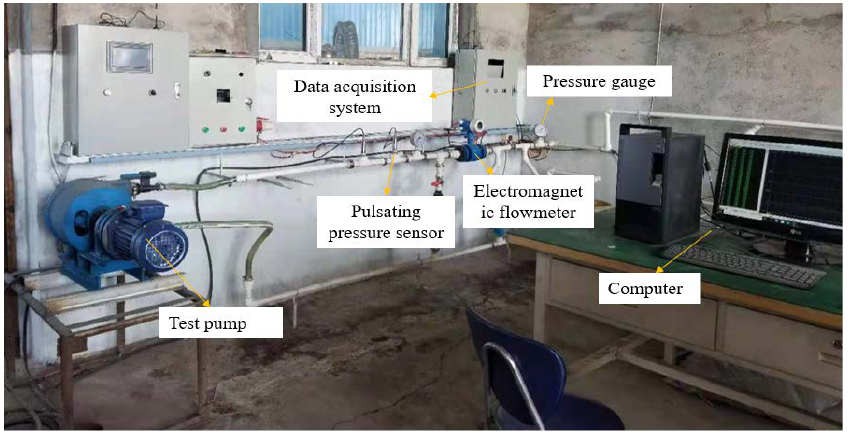
Figure 7. Test system of the test pump.